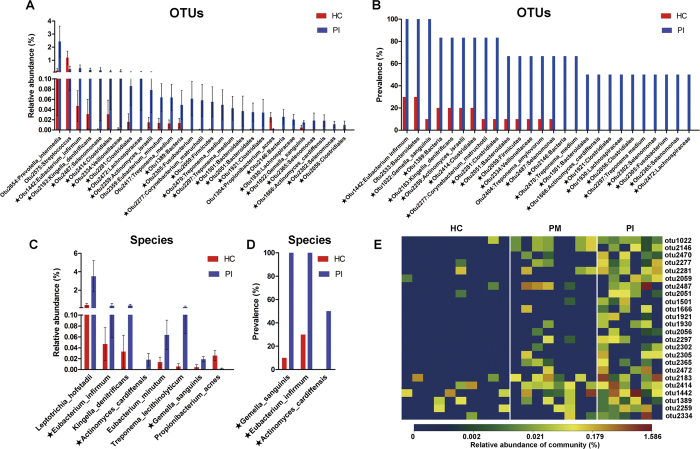
OTUs and taxa differing between healthy implant (HC) and peri-implantitis (PI) sites.(A) A total of 29 OTUs exhibited significant differences in mean relative abundances between HC and PI sites (Wilcoxon rank-sum test, P < 0.05). The bars show mean ± SEM relative abundances. In total, levels of 27 OTUs were higher in PI. (B) OTUs differing in terms of detection frequency between HC and PI sites (Fisher’s exact test, P < 0.05). (C) Species differing in terms of relative abundance between HC and PI sites (Wilcoxon rank-sum test, P < 0.05). The bars show mean ± SEM relative abundances. (D) Species differing in terms of detection frequency between HC and PI sites (Fisher’s exact test, P < 0.05). OTUs or species marked with stars (★) differed significantly in terms of both relative abundance and detection frequency. (E) A heat map of the relative abundances of OTUs that differed significantly between health and disease. The diagram shows OTUs that differed both in relative abundance (Wilcoxon rank-sum test, P < 0.05) and frequency of detection (Fisher’s exact test, P < 0.05) in HC and PI sites. Peri-implant mucositis sites were intermediate in terms of both relative abundance and prevalence.